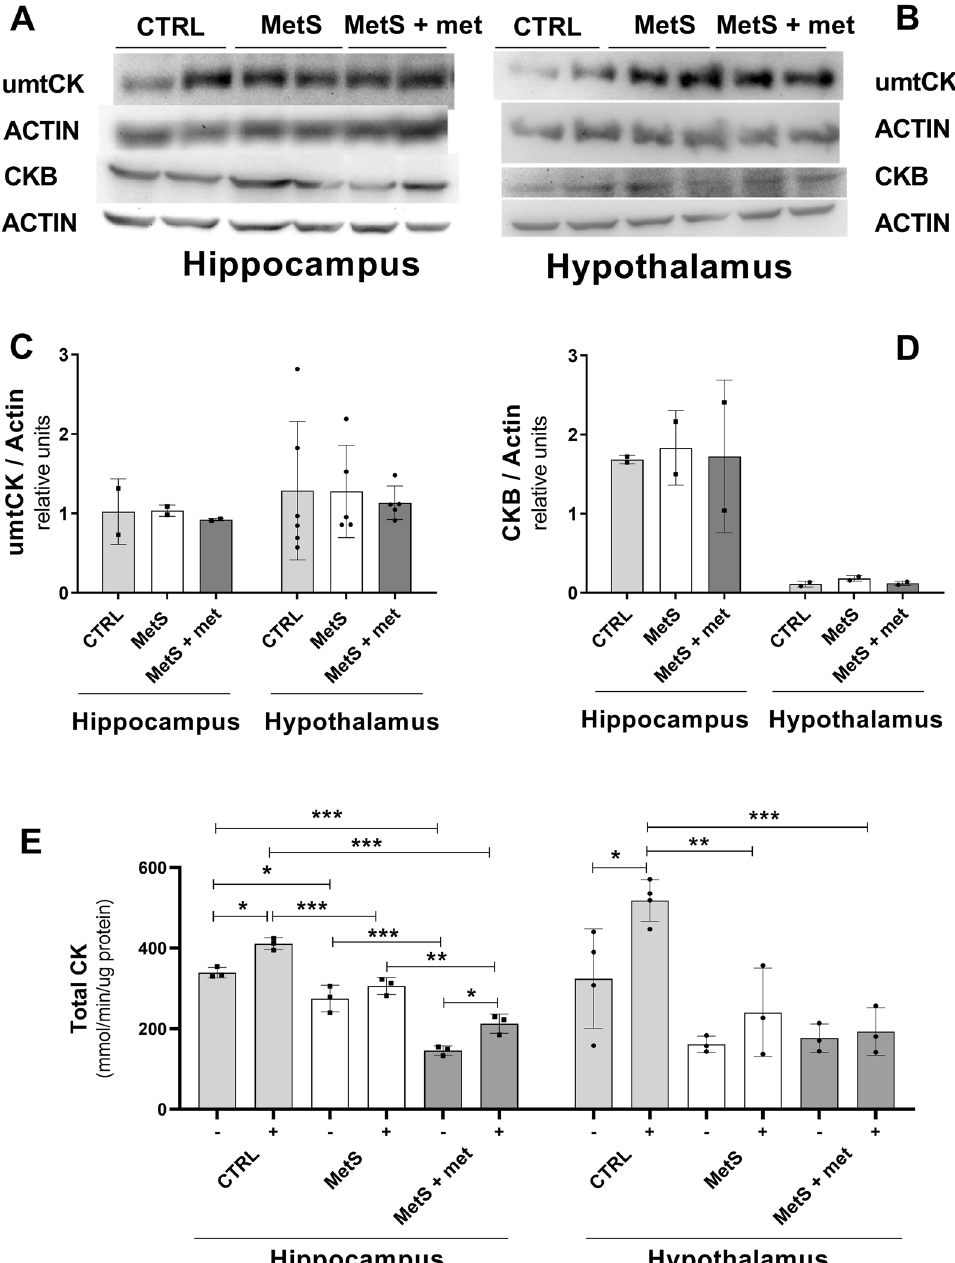
Figure 6. Effect of the metabolic syndrome (MetS) and metformin on ubiquitous mitochondrial (umtCK) and brain creatine kinase (CKB) expression as well as total creatine kinase (CK) activity. ( A , B ) Representative blots showing umtCK expression in the hippocampus and hypothalamus. ( C , D ) Densitometric analysis of umtCK and CKB expression in the hippocampus and hypothalamus ( E ) Total CK activity with or without dithiothreitol (DTT) in the hippocampus and hypothalamus. The data represent the mean ± SD. Sample size (N) CKB and hippocampal umtCK expression CTRL = 2, MetS = 2, MetS + met = 2; hypothalamic umtCK expression CTRL = 6, MetS = 2, MetS + met = 5; total CK activity with or without DTT in the hippocampus (all = 3) or hypothalamus (control with or without DTT = 4, all others = 3). *p ≤ 0.05, **p ≤ 0.01, ***p ≤